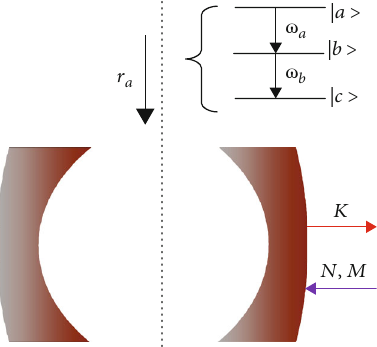
Figure 1: Schematic representation of a nondegenerate three-level laser coupled to squeezed vacuum